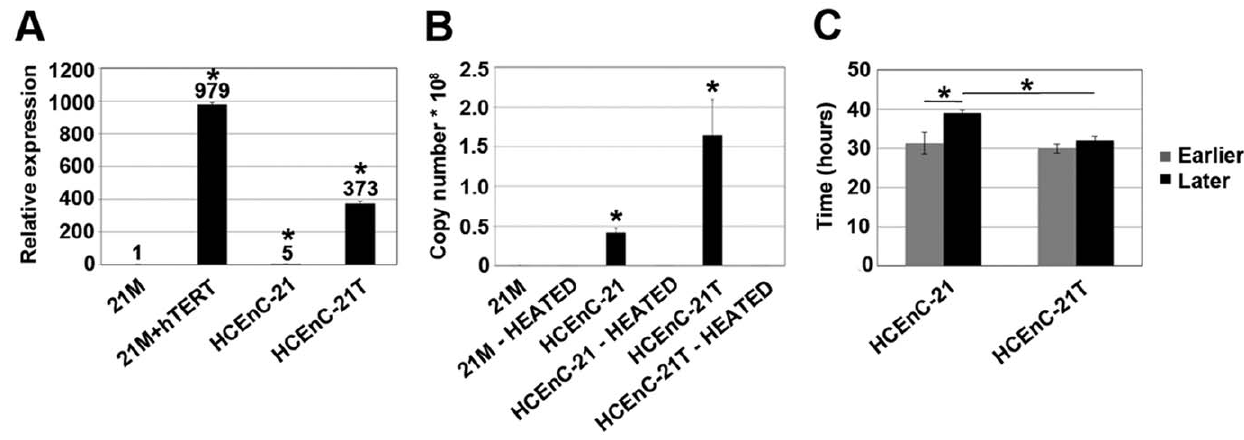
Figure 2. Telomerase expression, telomerase activity and cell doubling time. (A) Telomerase mRNA levels relative to 21M primary cells were detected by real-time PCR. Telomerase-transduced primary (21M + hTERT) and HCEnC-21 cells (HCEnC-21T) showed strongly elevated telomerase mRNA levels. Importantly, non-transduced HCEnC-21 cells also expressed significantly higher levels of telomerase mRNA than 21M primary cells. (B) Telomerase activity indicated as template copy number was measured in cell extracts using the telomeric repeat amplification protocol (TRAPeze RT). Heat-inactivated extracts served as negative controls. No specific telomerase activity was detected in 21M primary cells, while HCEnC-21T cell lysates contained strongly elevated telomerase activity. Note that HCEnC-21 intrinsically upregulated endogenous telomerase activity. (C) Cell doubling time of earlier (19–24) and later (32–41) passages of HCEnC-21 and HCEnC-21T. Cells were plated in 12-well plates at a density of 50,000 cells/well and counted after 2, 3, and 4 days using a hemocytometer. HCEnC-21T showed a higher proliferation rate compared to HCEnC-21 in long-term cultures. Error bars indicate mean 6 SEM. *, P , 0.05.